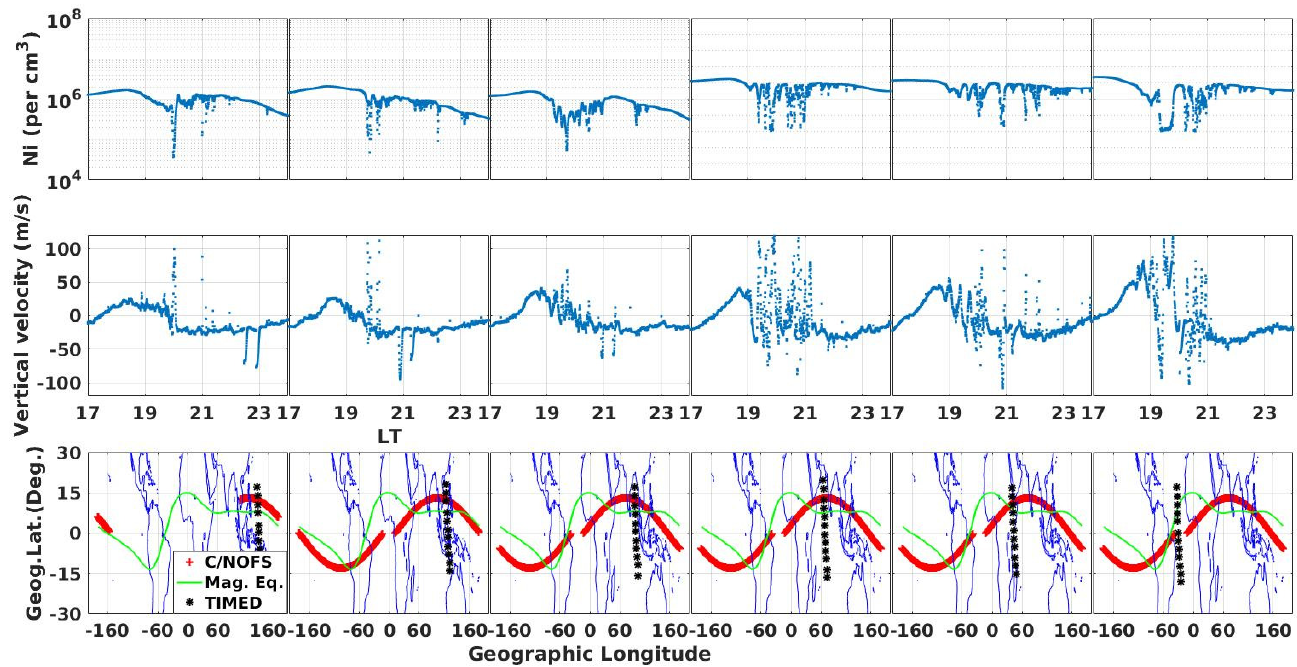
Figure 1. Irregular ion density ( top row ) and plasma vertical drift velocity ( middle row , positive and negative values represent upward and downward, respectively) from C/NOFS and coordinates of data from C/NOFS and SABER satellites ( bottom row ) versus LT on 15 October